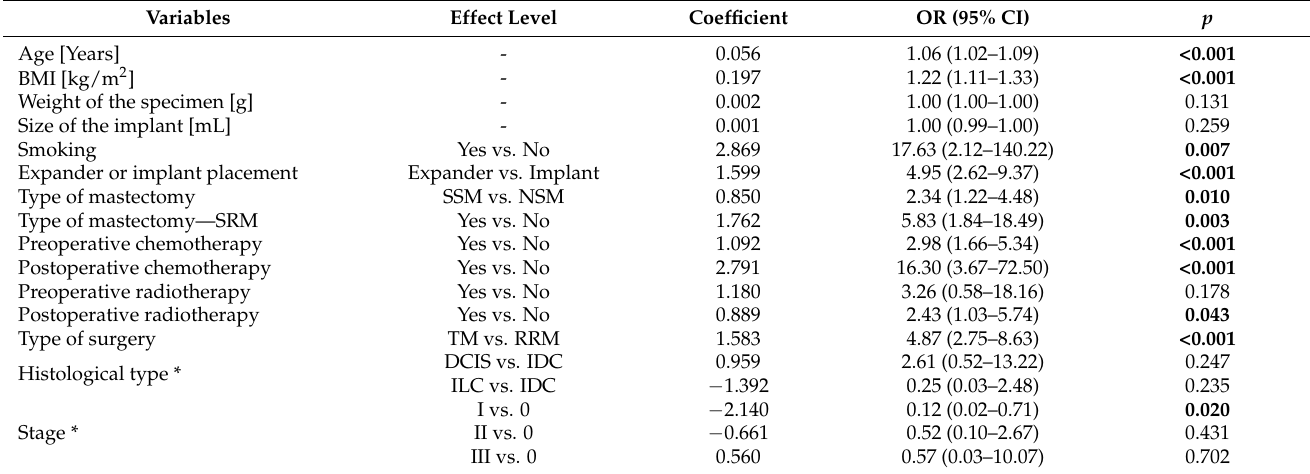
Table 4. Univariate logistic regression of factors potentially associated with the composite endpoint (postoperative minor and major complications including presence of seroma).